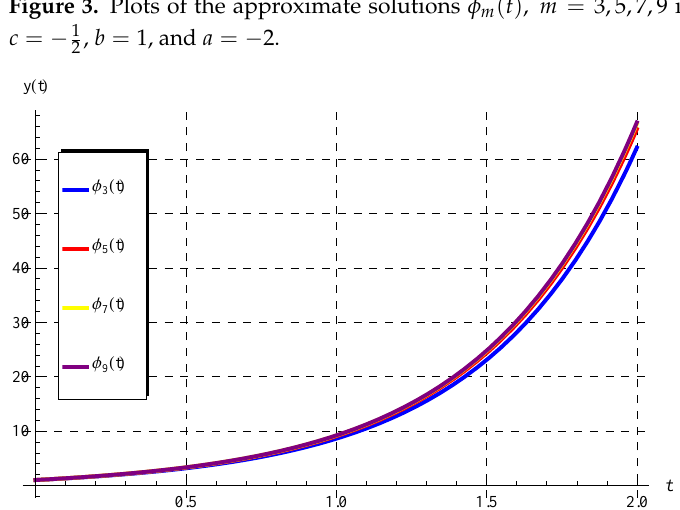
Figure 4. Plots of the approximate solutions φ m ( t ) , m = 3,5,7,9 in Equation (38) vs. t at λ = 1, c = − 1 , b = 1, and a = 2